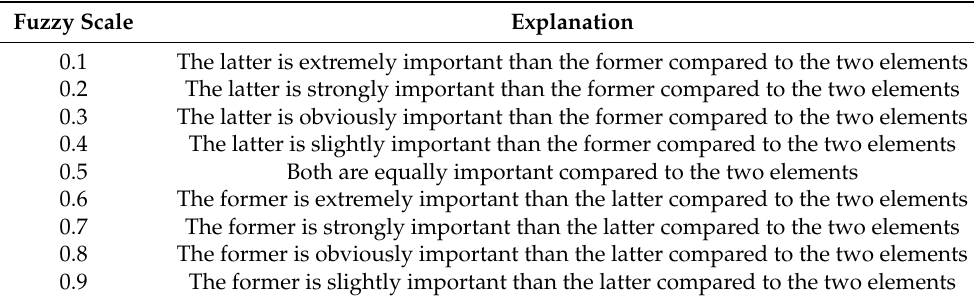
Table 3. Fuzzy scale and method.